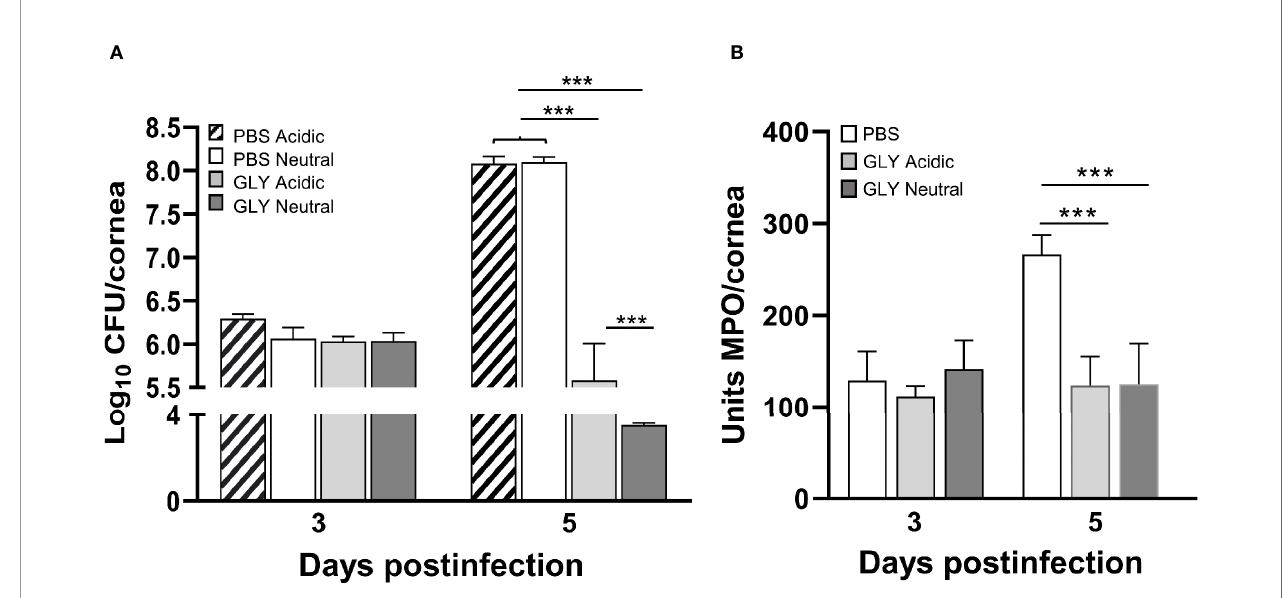
FIGURE 4 | Bacterial plate count and MPO in corneas infected with KEI 1025. (A) Bacterial plate counts at 3 and 5 days p.i. after acidic or neutral GLY vs . PBS (adjusted to acidic or neutral pH) treatment show signi fi cant reduction only at 5 days p.i., and GLY at neutral pH was slightly but signi fi cantly better than acidic pH (B) . MPO levels measured at 3 and 5 days p.i. after acidic or neutral GLY vs . PBS show signi fi cant reduction only at 5 days p.i. Data are expressed as mean ± SEM (***p < 0.001, n =